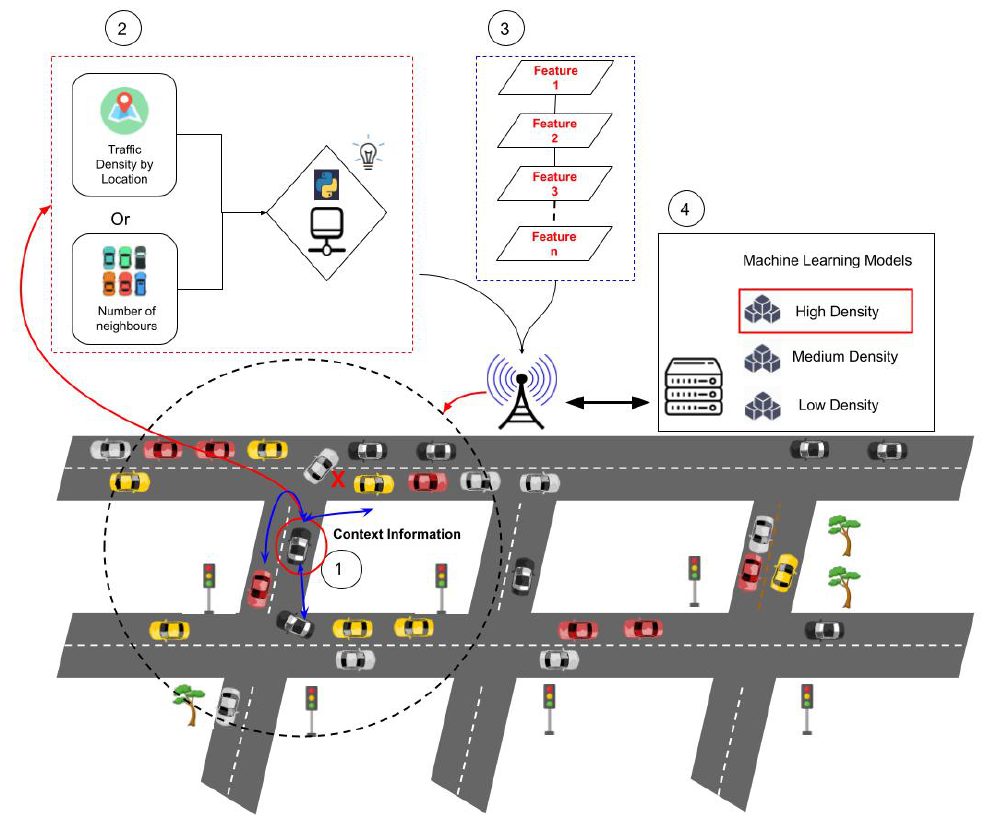
Figure 10. Flow of the prediction process with different context